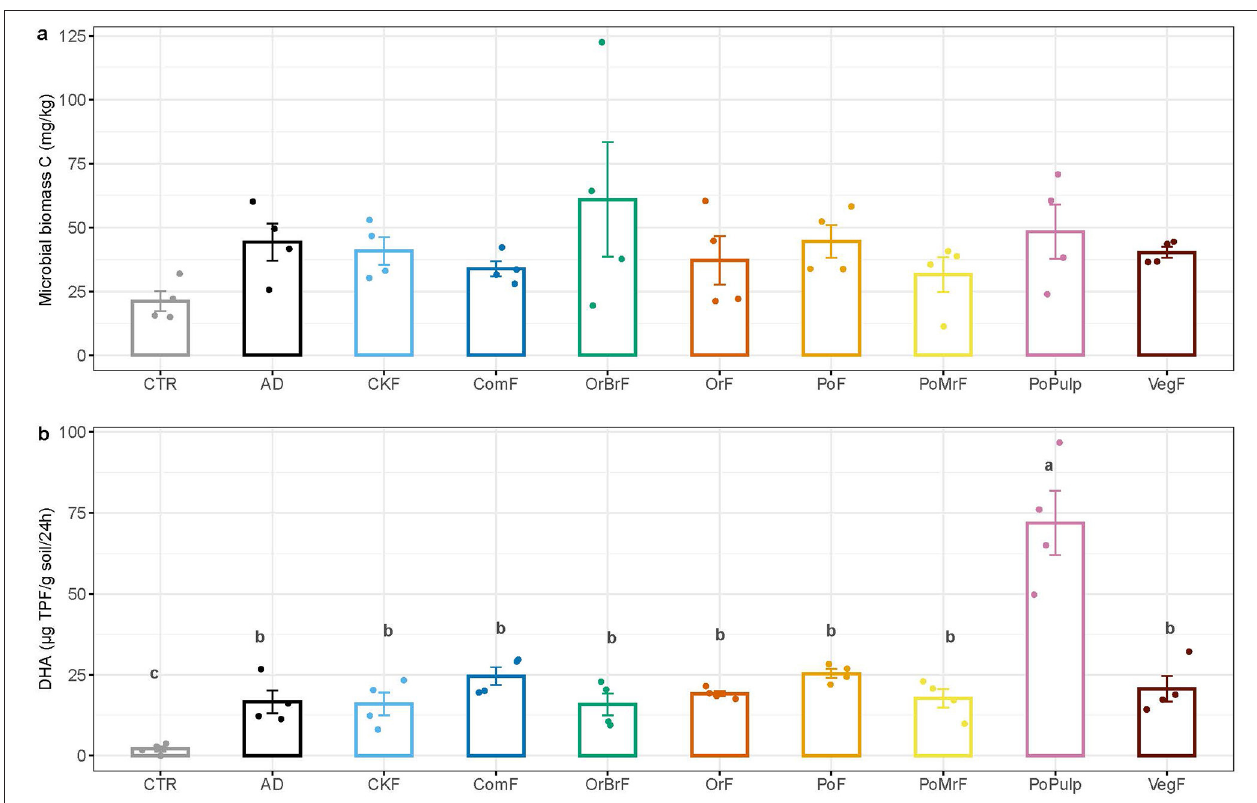
FIGURE 8 | Mean values of the microbial biomass C (A) and dehydrogenase activity (B) at the end of the plant growth pot experiment ( n = 4 ±